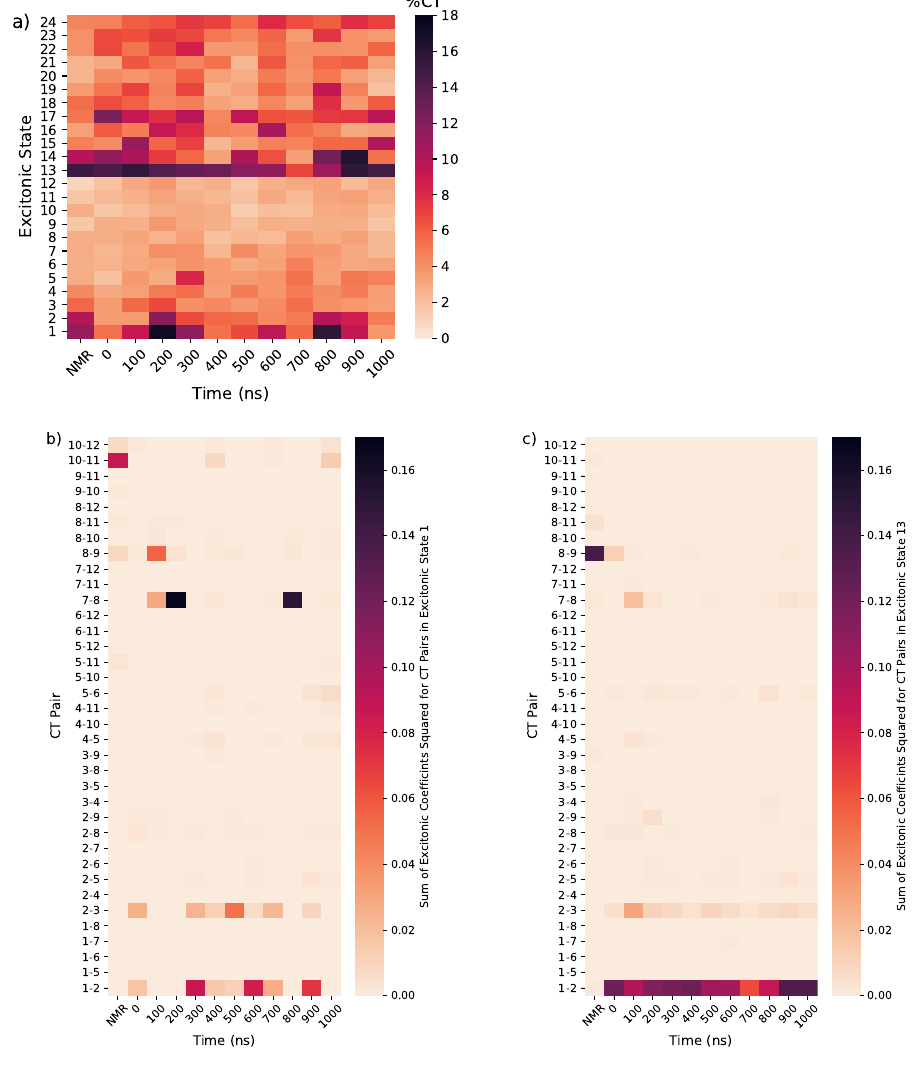
Figure 8. ( a ) Percentage involvement of CT states in the lowest 24 excitonic states for Tel21 in the NMR structure and MD snapshots; contribution of pairs of guanines to the CT states in excitonic state ( b ) 1 and ( c )